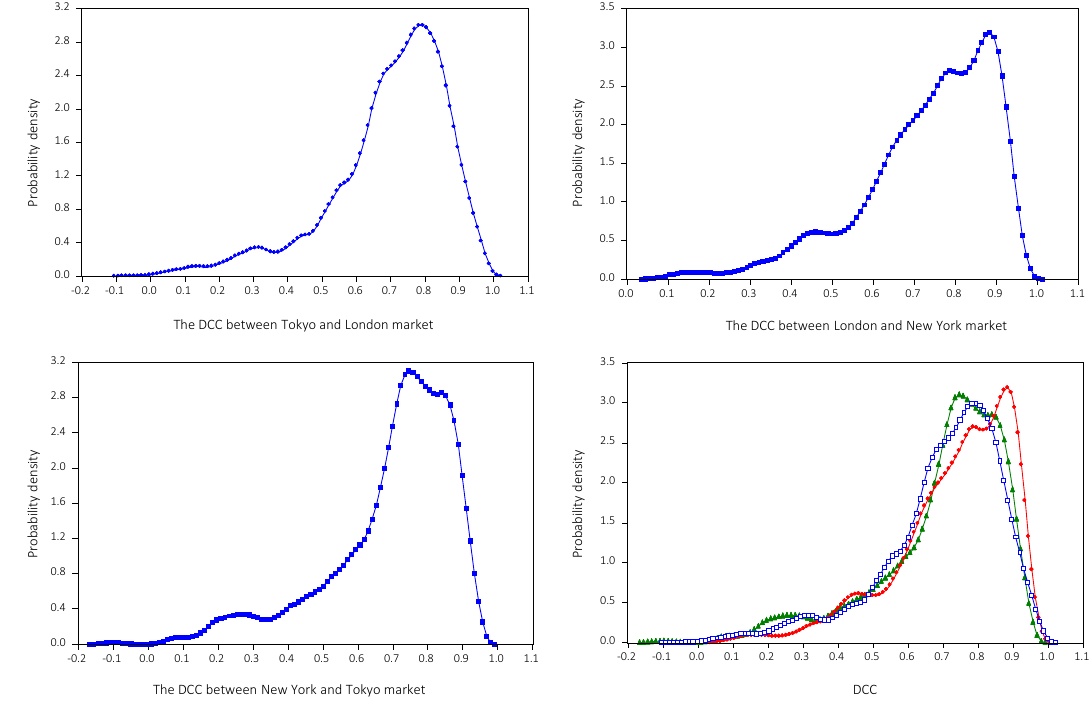
Figure 1. Distributions of dynamic conditional correlations for the Tokyo, London, and New York gold markets over the sample